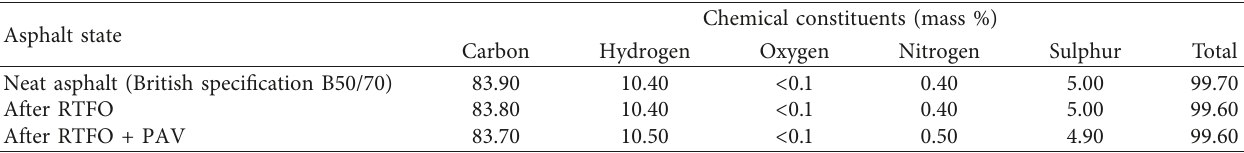
Table 1: Asphalt chemical constituents and their share. The table is reproduced from Stangl et al. [5] (under the creative commons attribution license/public